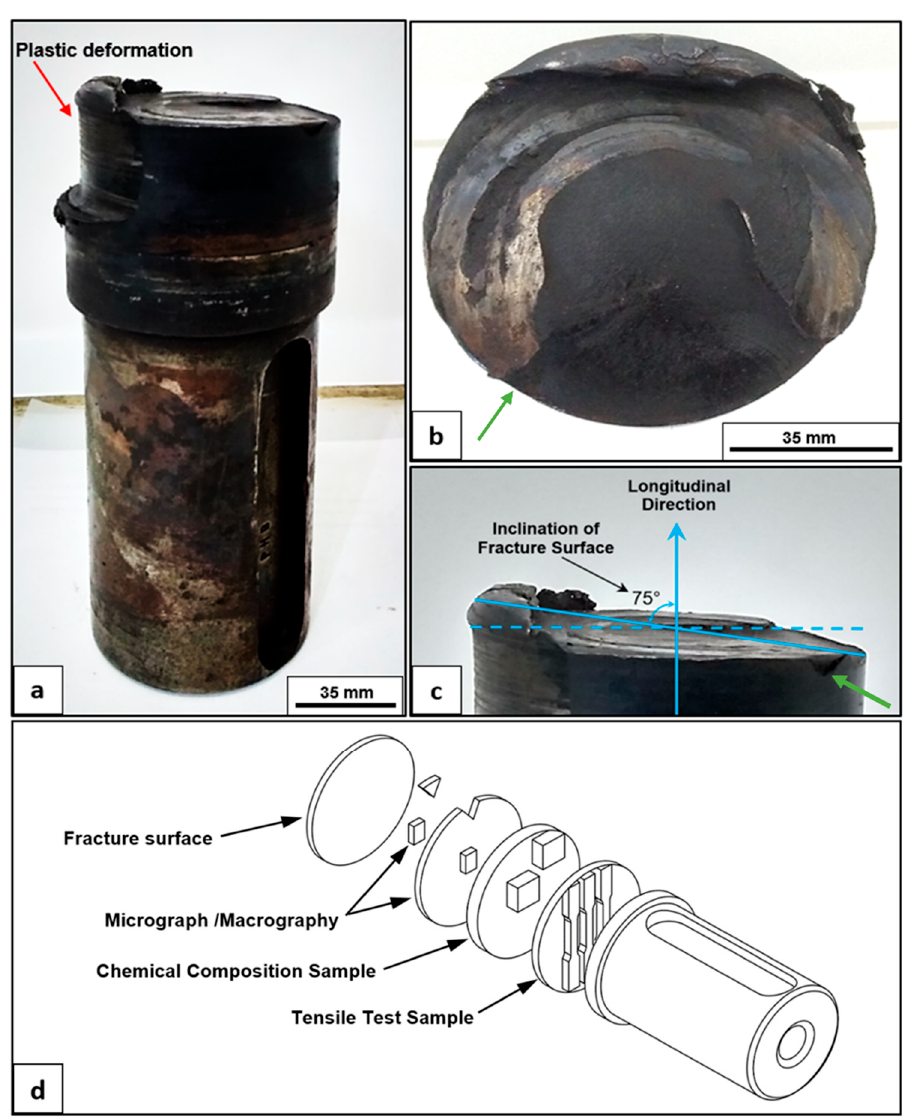
Figure 3. Fractured reducer shaft: ( a ) Side view showing the plastic deformation (red arrow) of the material under the fracture surface, ( b ) top view (fracture surface before cleaning), ( c ) fracture surface slope, ( d ) samples for the characterization and analysis withdrawn from the shaft. Green arrows indicate crack nucleation area.